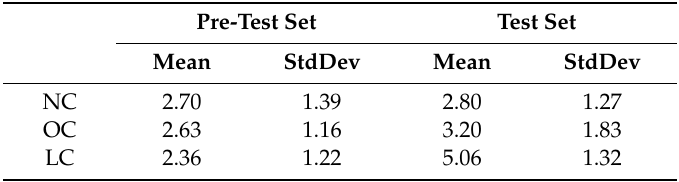
Table 1. The mean and standard deviation of each set score (NC: no cue, OC: oblique cue, and LC: leading cue).